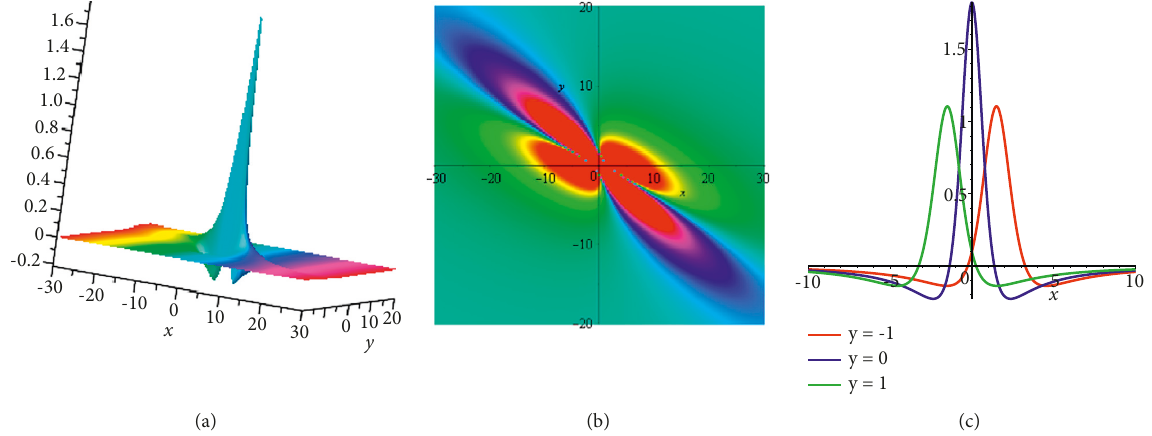
Figure 1: Plot of equation (44) by taking a � 1 . 5 , b � 1 . 1 , c